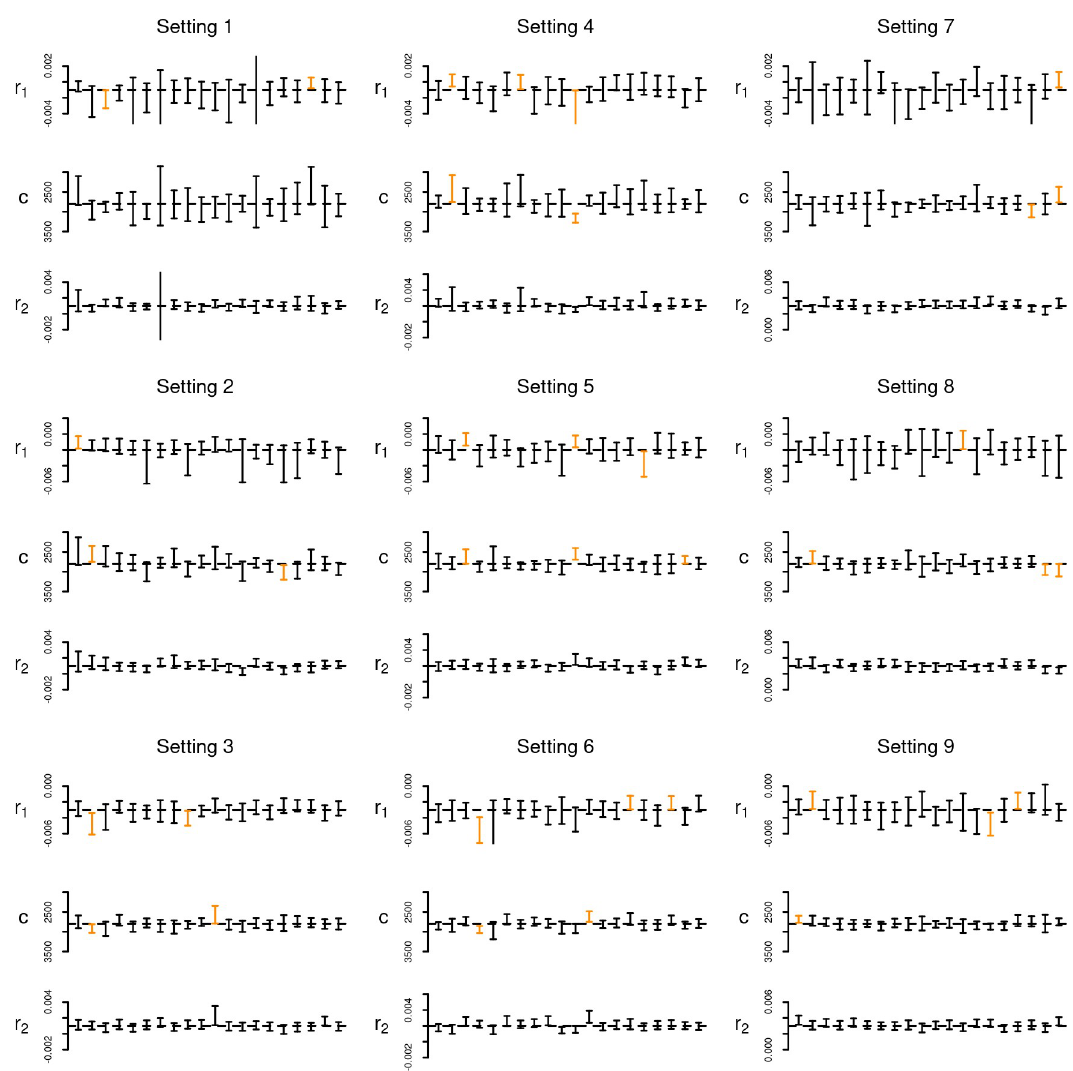
Fig 6. Results of experiment 4. Error bar represents the estimated 90% HPD interval for each run; cases where the true parameters were not within the interval are displayed in orange.